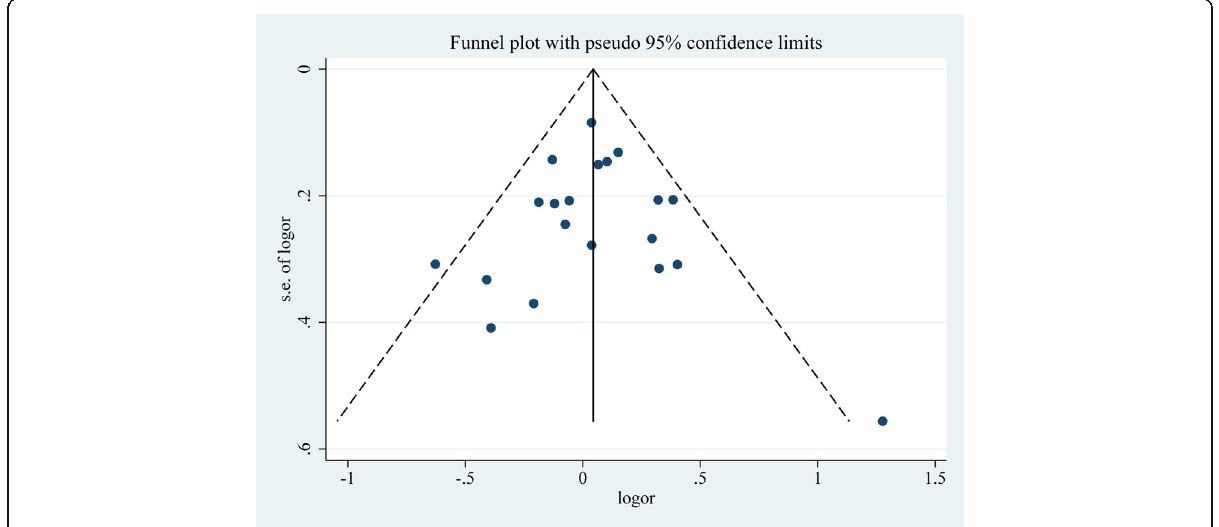
Fig. 4 Funnel plot analysis of the included studies on TNF- α 308G/A